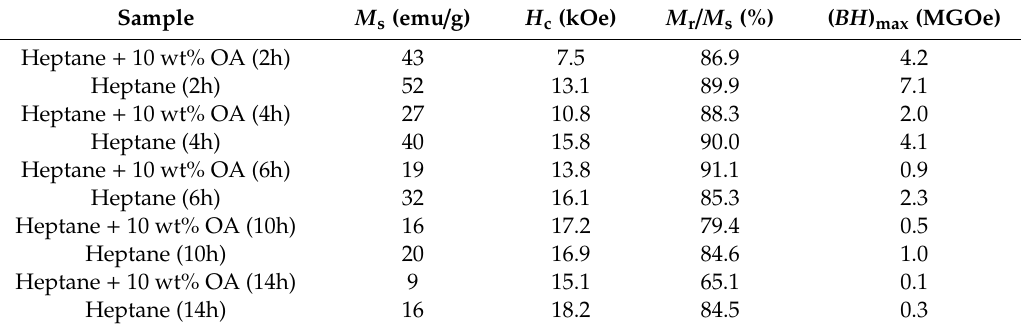
Figure 7. ( a ) Hysteresis loops and ( b ) Variation of coercivity, M s with milling time of Mn 55 Bi 45 powders obtained by LEBM. Table 1. Change of the main magnetic properties of Mn 55 Bi 45 powders obtained by di ff erent ball milling processes after di ff erent milling time.